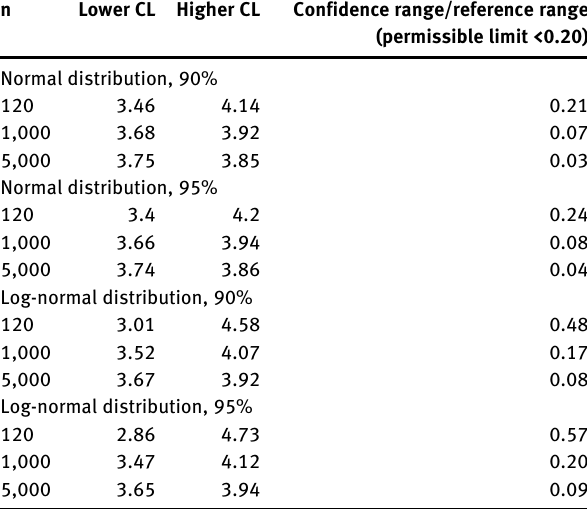
Table  : Con fi dence intervals (CI) depending on the number of ob- servations (n) for thyrotropin, TSH (taken from ref. [ 